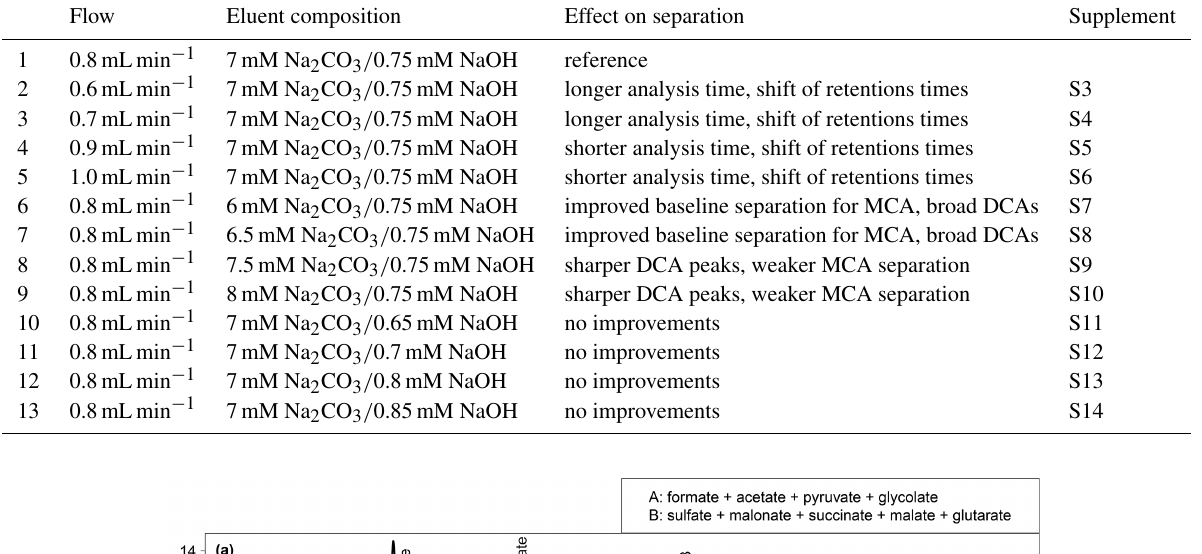
Table 2. Overview of the varied flows and eluent compositions in the isocratic system using the Metrosep A Supp 16 250mm column with their effects on separation and reference to the corresponding figures in the Supplement.